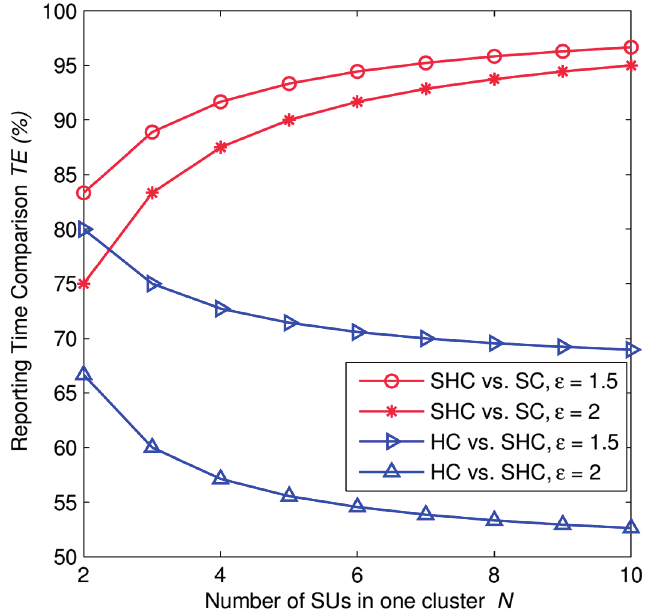
Figure 10. Time efficiency TE (%) as a function of the number of SUs in one cluster with K = 5